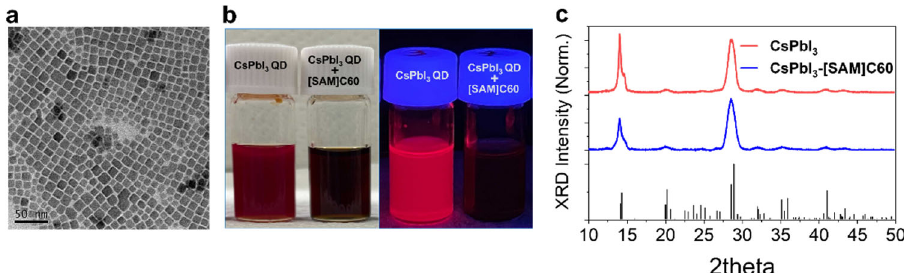
Figure 1. ( a ) Transmission electron microscopy (TEM) image of CsPbI 3 QDs. ( b ) Digital images of CsPbI 3 QDs and CsPbI 3 -[SAM]C60 QD dispersions under room light (left) and excitation using an ultraviolet lamp (right) at room temperature, separately. ( c ) XRD of CsPbI 3 QDs and CsPbI 3 - [SAM]C60 QDs. The black line is the PDF card of γ -CsPbI 3 .